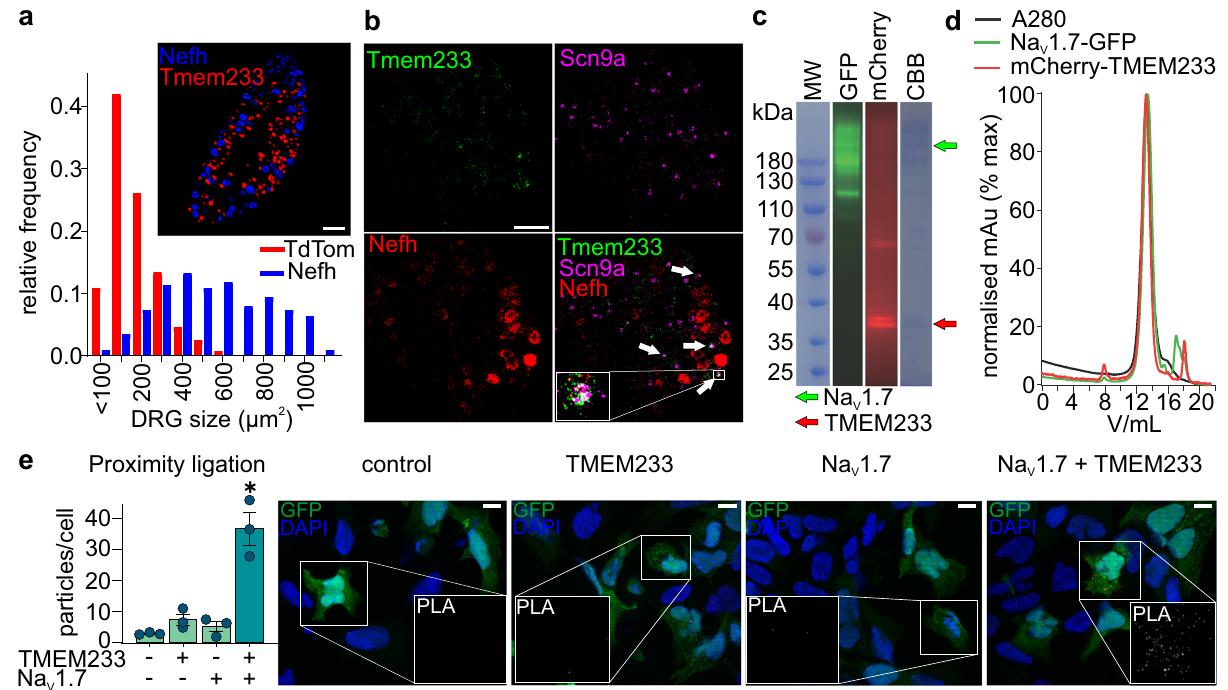
fl uorescence and mCherry fl uorescence of the same SDS-PAGE gel. The green and red arrow indicate Na V 1.7-GFP and mCherry-TMEM233 bands, respectively. MW, molecular weight marker (kDa). d Normalized size-exclusion chromatography pro fi le of the puri fi ed Na V 1.7-TMEM233 complex. Signals of total protein (black), GFP (green) and mCherry (red) were detected simultaneously. e Left: Quanti fi ca- tionofproximityligationassaysignalinGFP-positiveHEK293cellstransfectedwith GFP as well as N-terminal FLAG-tagged hNa V 1.7 and N-terminal HA-tagged TMEM233 alone or in combination. Right: Representative images showing nuclei (DAPI,blue),GFP(Green)and proximityligationsignal(red channel,enlargedview in inset shown in grayscale for clarity). Scale bar, 10 μ m. Data are shown as mean±SEM; *, p<0.05. n values and statistical information are detailed in Sup- plementary Table 1. Source data are included as a Source Data fi